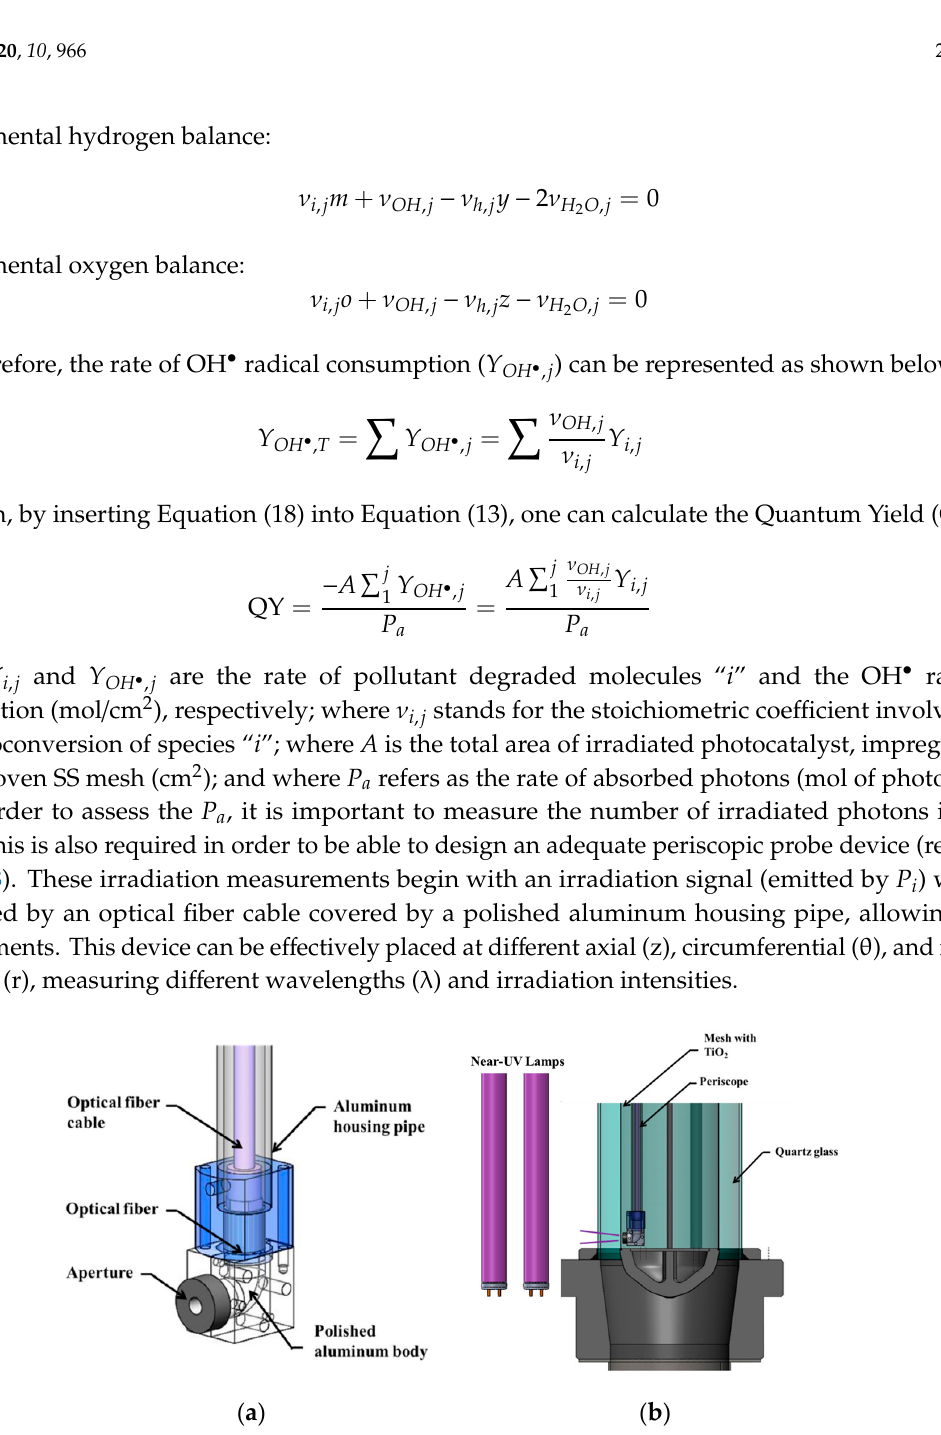
Figure 18. ( a ) Schematic description of the optimal periscopic probe and ( b ) periscope probe orientation in the PCAR. Reproduced by permission of chemical engineering Science [15].